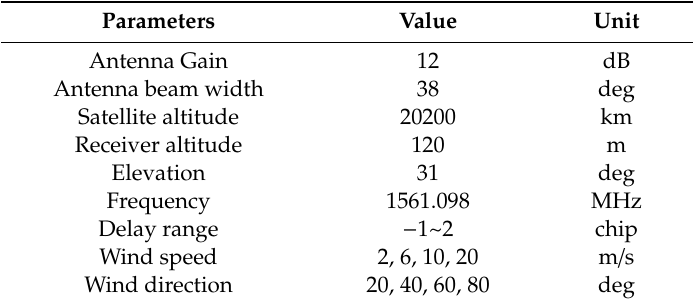
Table 1. Simulation